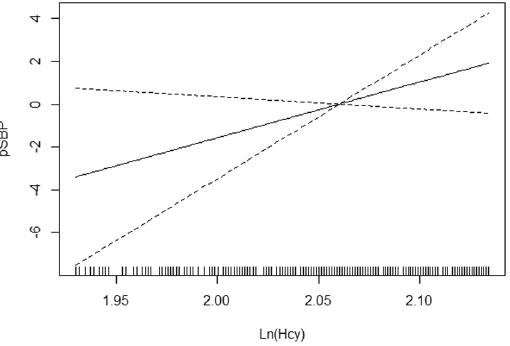
Figure 2. Smoothing curve of pSBP by lnHcy. Adjusted: age, sex, body mass index, smoking status, drinking status, serum creatinine, diabetes mellitus, dyslipidemia, cardiovascular disease, antihypertension drug use.